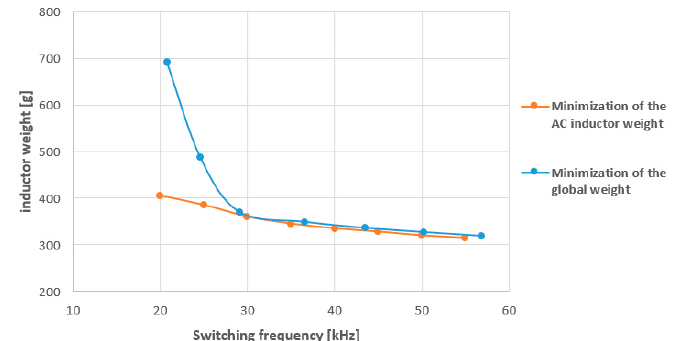
Figure 14. Comparison of the inductor weight: optimized separately and optimized with the converter.